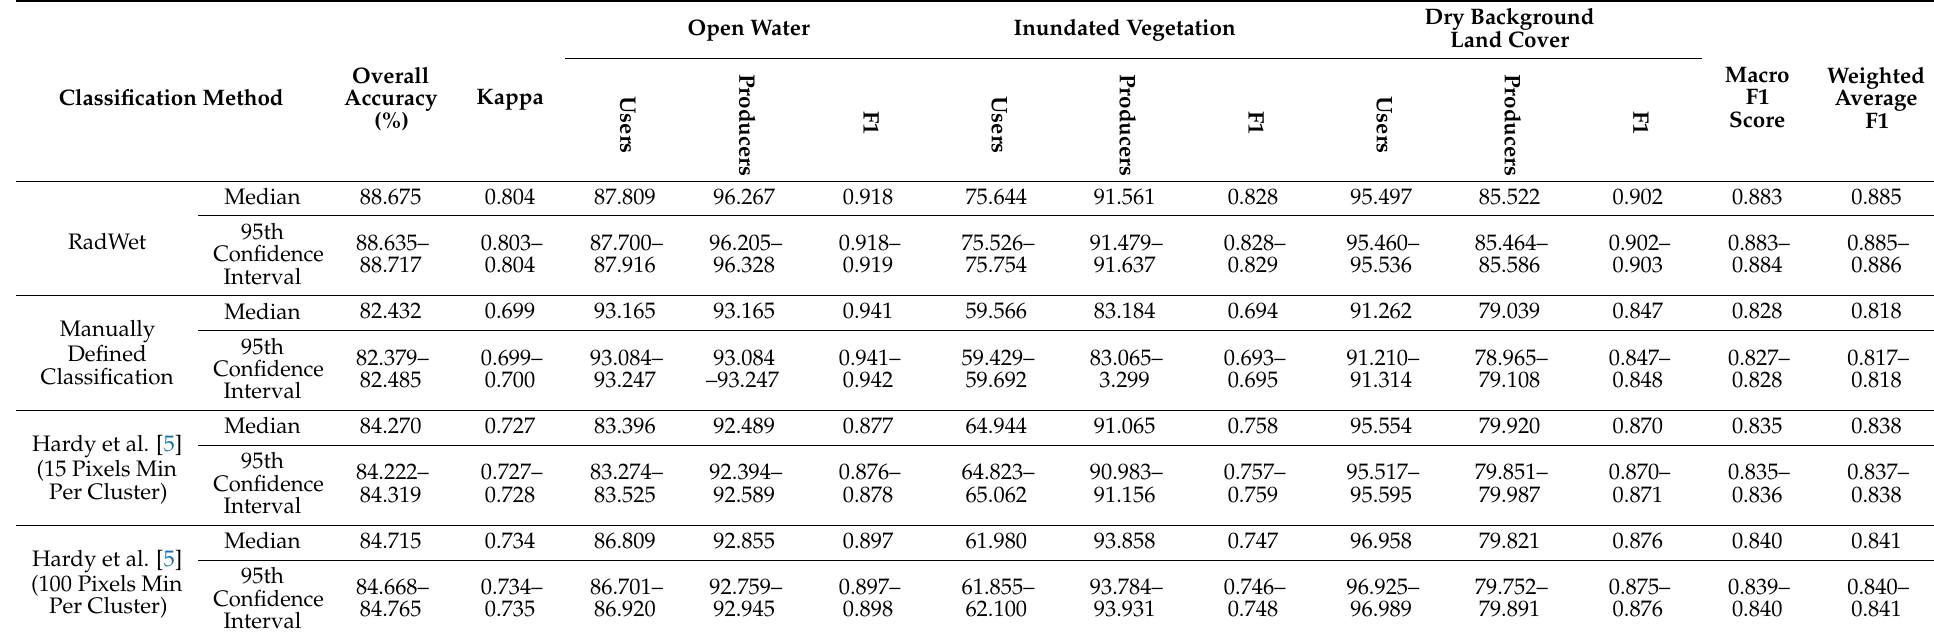
Table 4. Summary of Barotseland Floodplain classification accuracy assessment results.